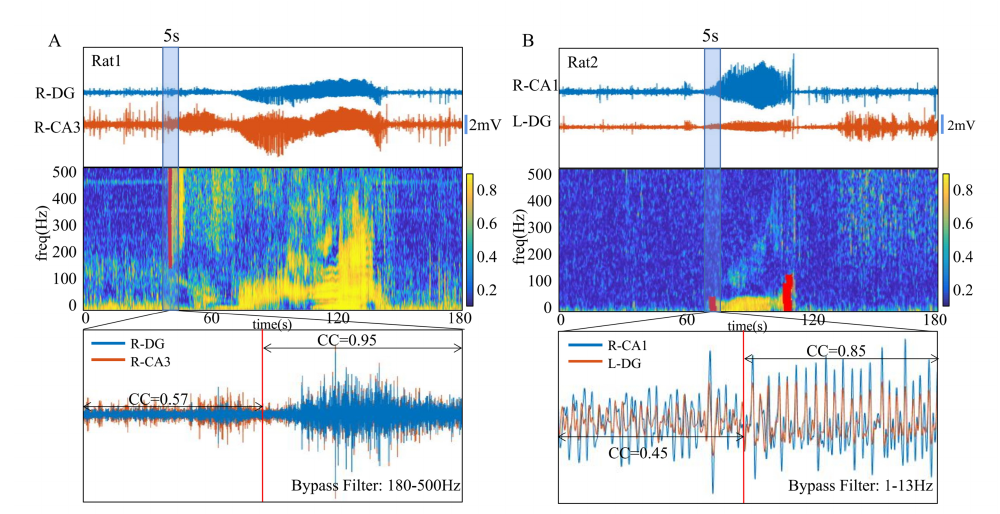
Figure 3. Two typical edge detection results of MSC maps. ( A ) The high-frequency band results from Rat-1. ( B ) The low-frequency band results from Rat-2. The red line is the Canny edge detection algorithm result. We subsequently enhanced the edge area, and there are obvious changes of correlation on both sides of the edge of the specific frequency band detected by the Canny edge detection